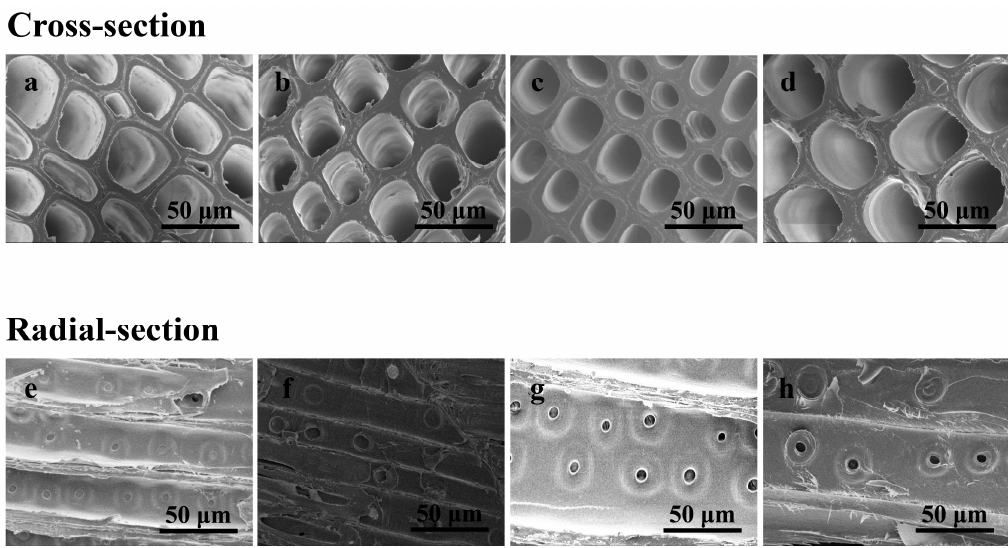
Figure 3. SEM photographs of wood samples. Cross-section: ( a ), control sample, ( b ), sample treated with P 1 , ( c ), sample treated with P 2 , ( d ), sample treated with P 3 ; Radial-section: ( e ), control sample, ( f ), sample treated with P 1 , ( g ), sample treated with P 2 , ( h ), sample treated with P 3 .